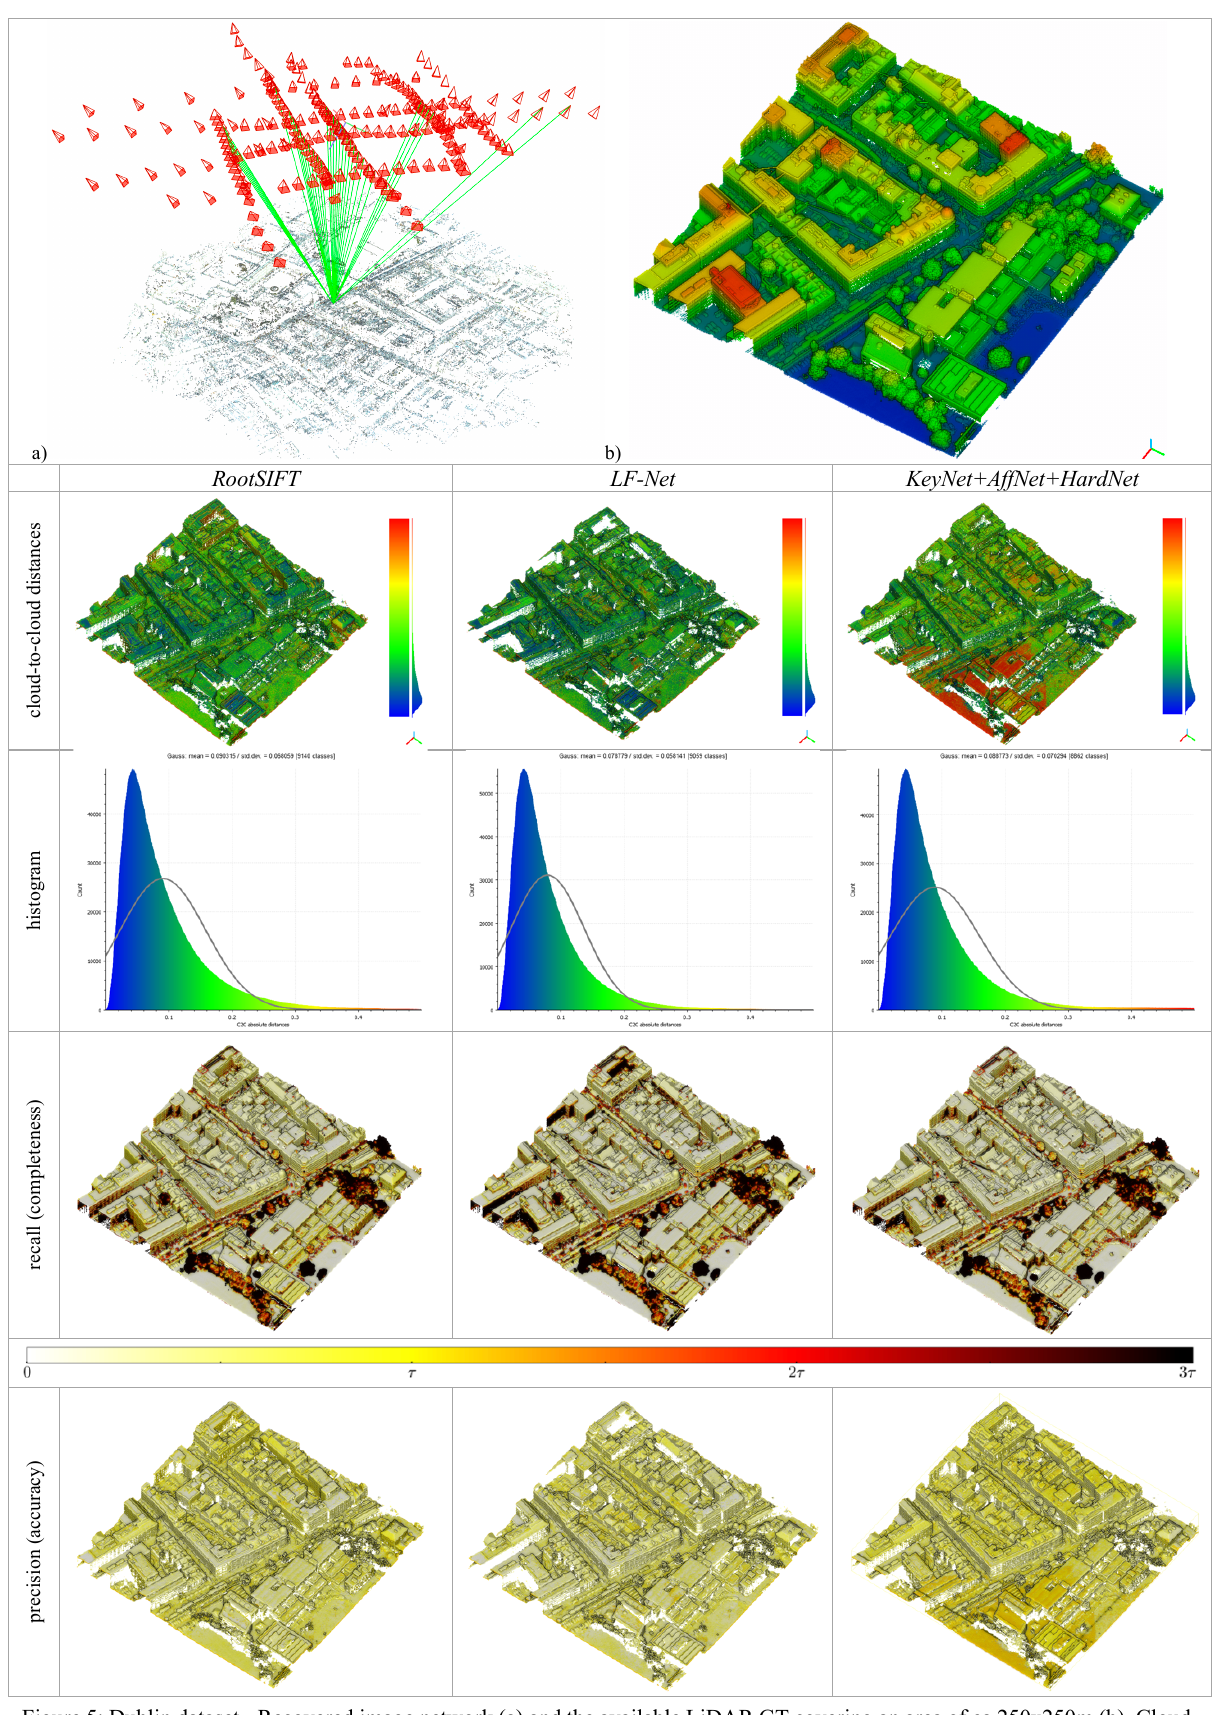
Figure 5: Dublin dataset - Recovered image network (a) and the available LiDAR GT covering an area of ca 250x250m (b). Cloud- to-cloud distances, histogram of point distances, recall and precision for the three MVS results obtained using the different ATs (rootSIFT, LF-Net and Key.net). Metrics in Table 5 and